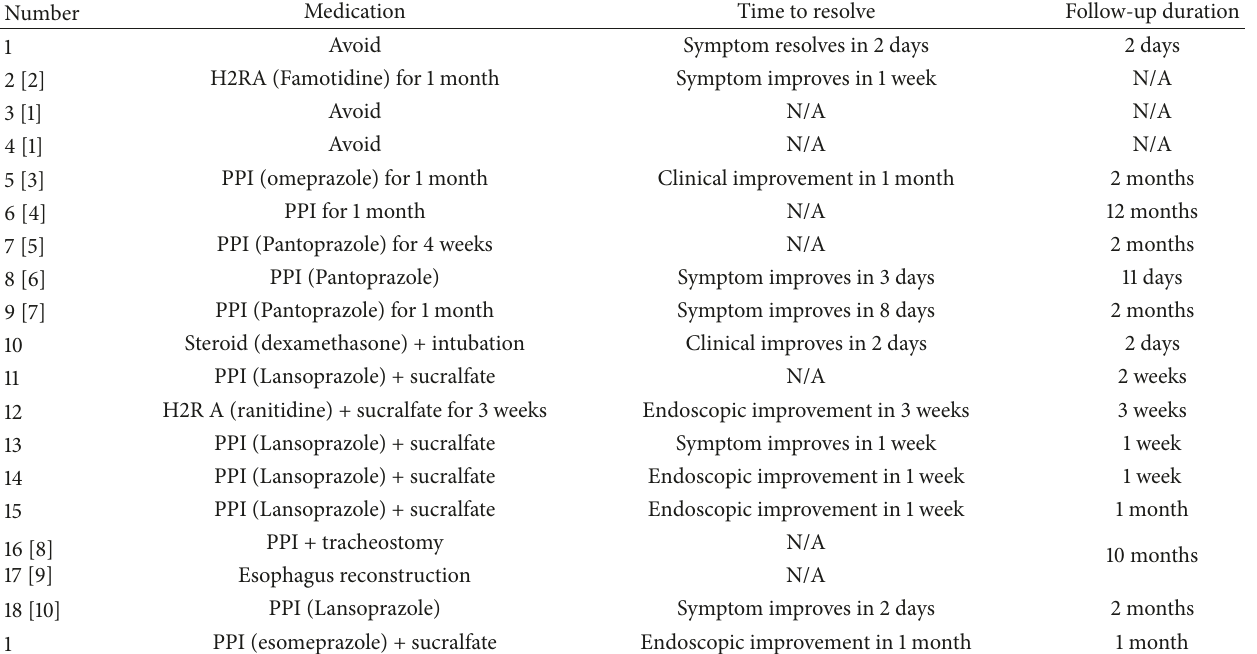
Table 3: Summary of treatment and follow-up duration in ETI published